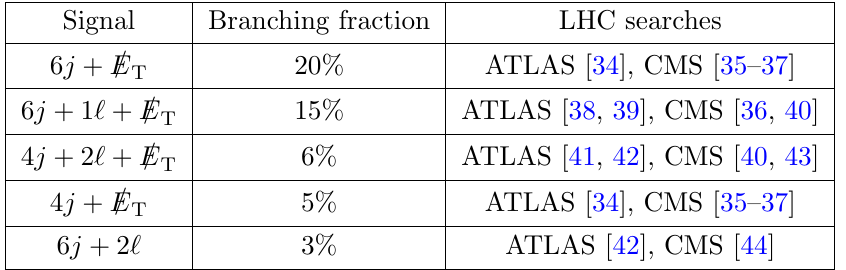
Table 2. Some of the signals that are produced by bi (cid:23) o production and subsequent decays in the model described in section 2 with their branching fractions and relevant LHC searches. Here the leptons ‘ = e; (cid:22) and j = u; d; s; c